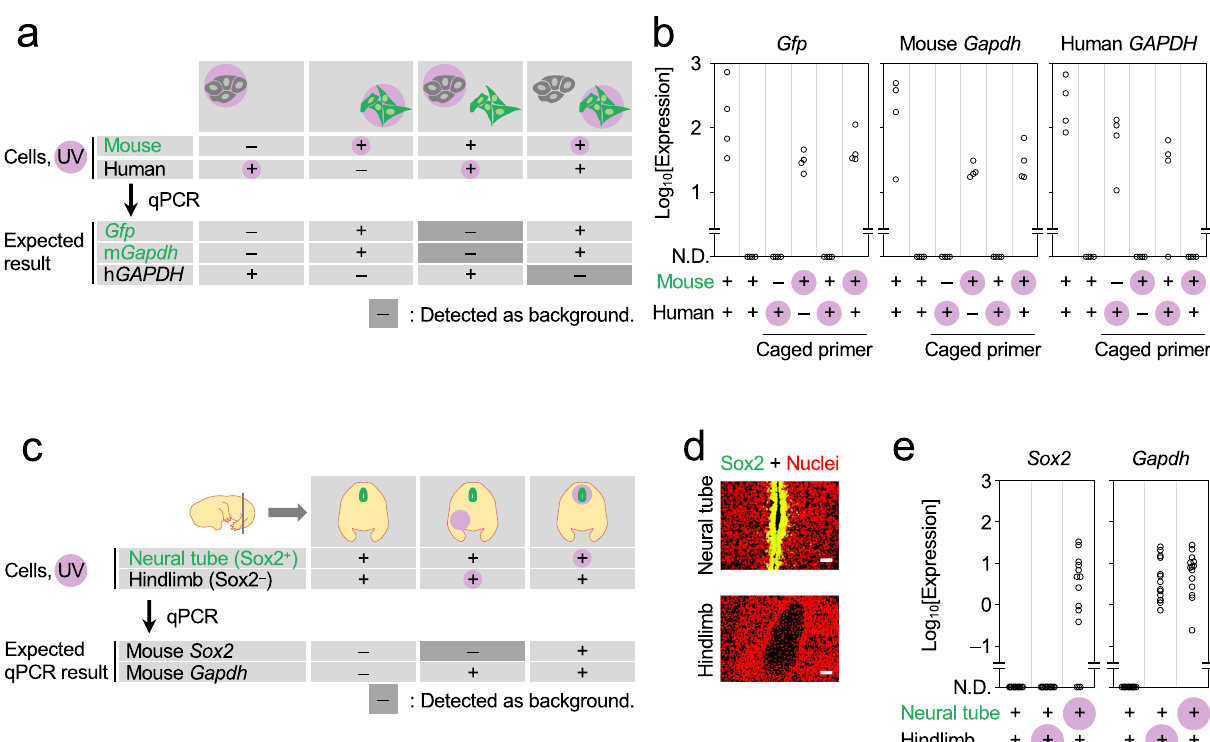
Fig. 2 Validation of PIC for ROI-speci fi c pro fi ling. a – e Experiments to evaluate the level of background from nonirradiated cells were performed with human – mouse mixed cultures ( a , b ) and E14.5 mouse embryos ( c – e ). After photo-irradiation (pink) of either human (T-47D, grey) or mouse (GFP- expressing NIH3T3, green) cells ( a ), the cDNAs of human ( GAPDH ) and mouse ( Gapdh and Gfp ) genes were examined ( b ). Mouse embryonic sections of Sox2-positive (neural tube, green) or -negative (hindlimb) cells ( c , d a representative image was shown out of the replicates) were photo-irradiated and the